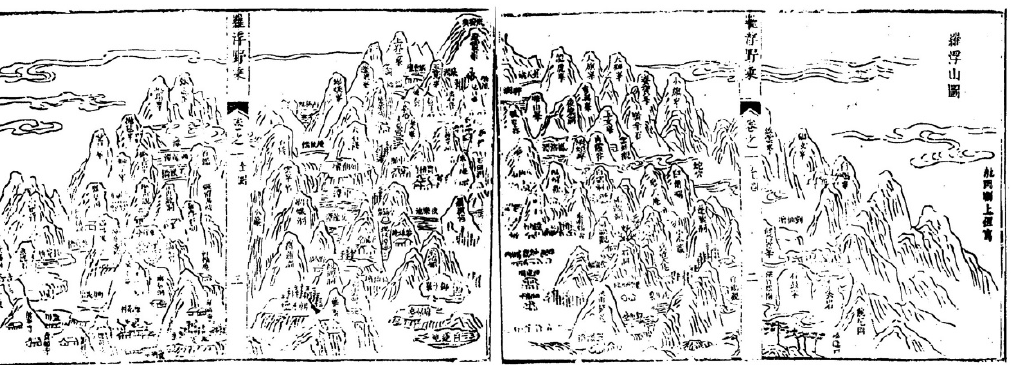
Figure 1. Panorama of the Luofu Mountains, 1639. Woodblock print. After Han Huang, Luofu yesheng , 1.2a–3b (480).